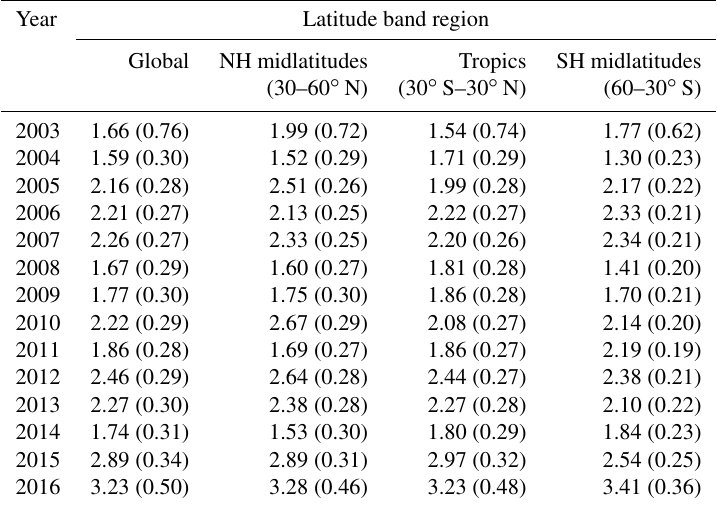
Table A1. Satellite-derived annual mean XCO 2 growth rates in ppmyear − 1 including 1 σ uncertainty (in brackets). Abbreviations: NH is Northern Hemisphere and SH is Southern